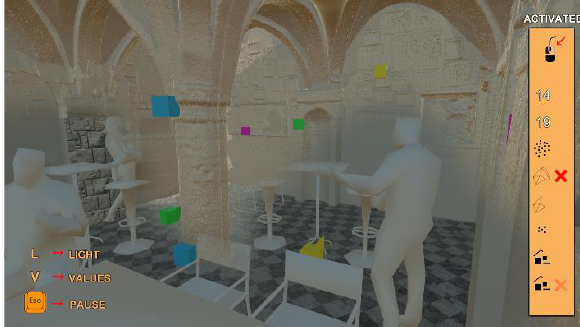
Figure 12 . This figure, adapted from screenshots extracted from the virtual environment, shows the overlay of a mesh representing the current state of Notger room with a project proposal. Identified values are also visible to enable users to evaluate the proposal's coherence with the space's cultural